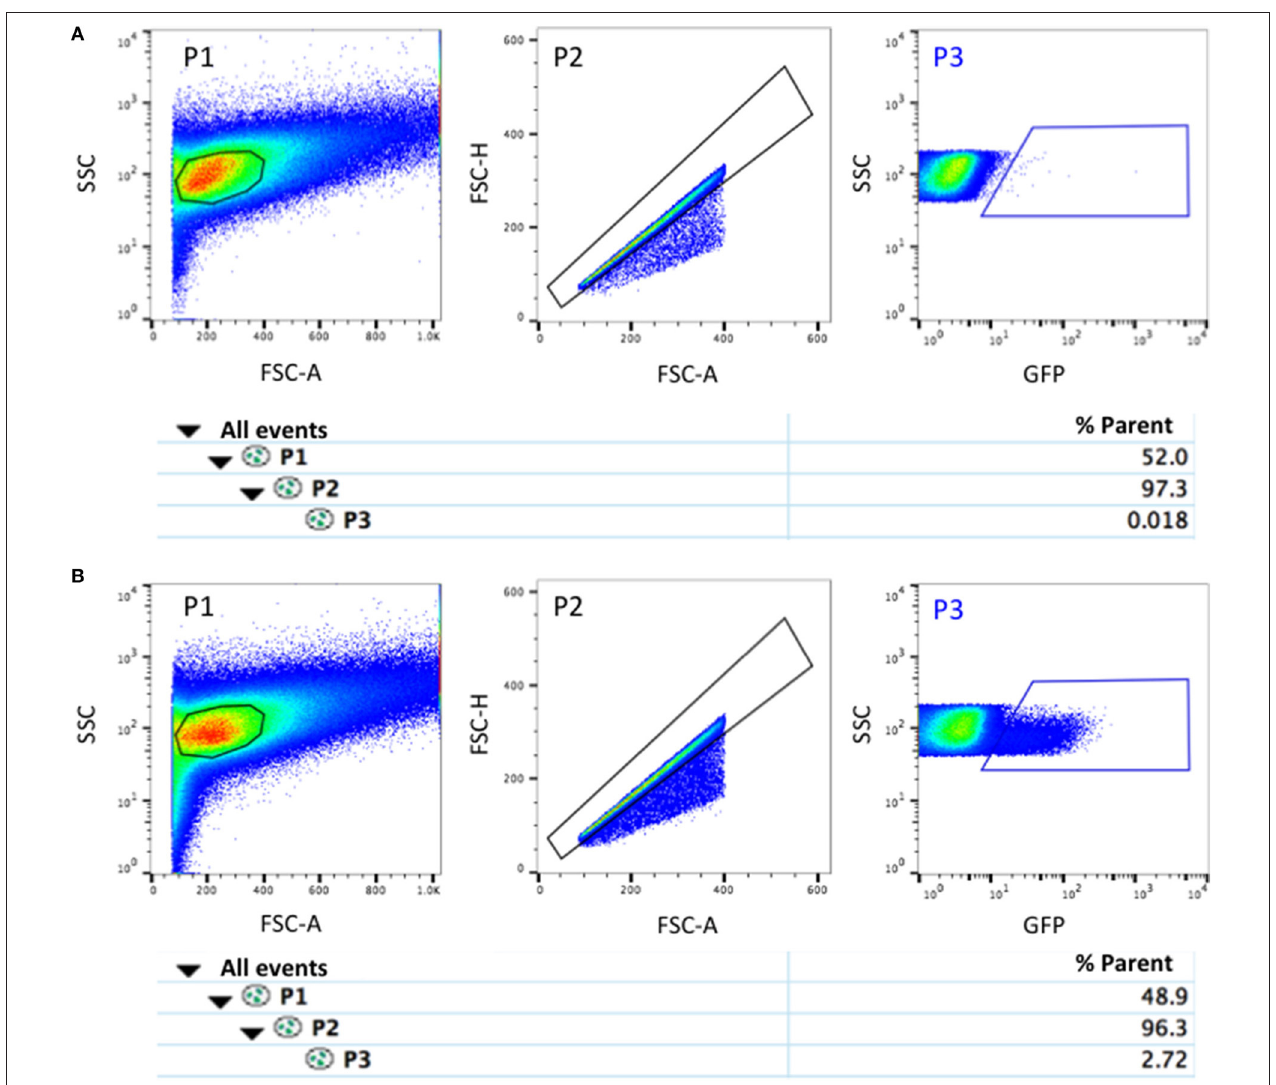
FIGURE 7 | Representative FACS profiles of fetal myogenic progenitors. (A) Profile of cells obtained after digestion of E15.5 WT fetuses (GFP − ve controls). (B) Profile of myogenic progenitors obtained after digestion of E15.5 Myf5 GFP − P fetuses, as described in this protocol. Cells in P3 gate are myogenic progenitors. The population hierarchy is shown under the plots. Abbreviations: SSC, Side scatter; FSC-A, Forward scatter-Area; FSC-H, Forward